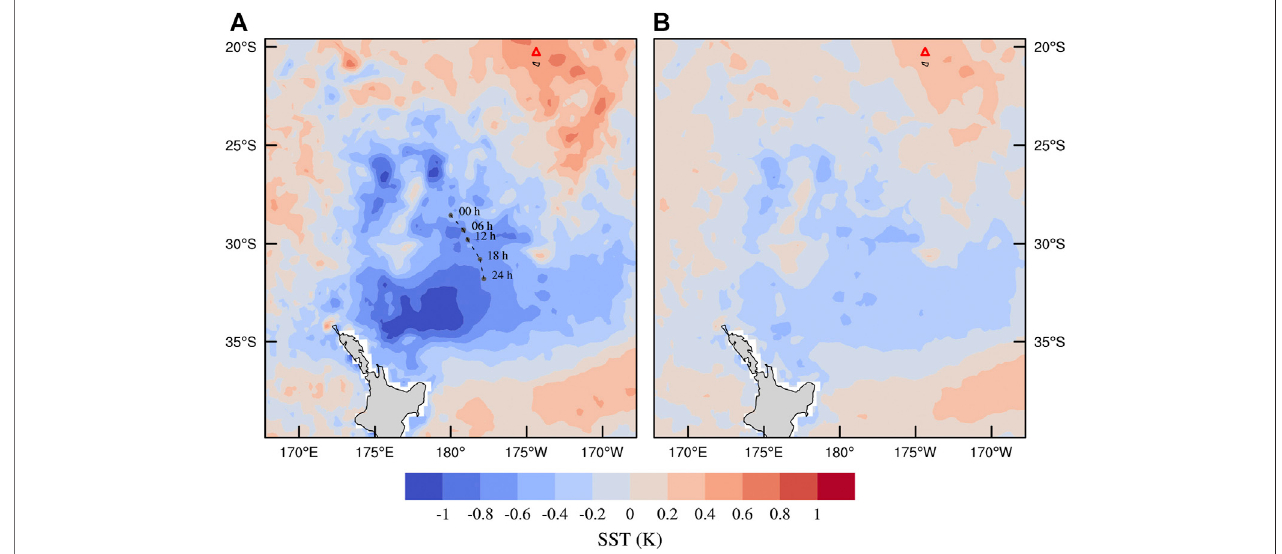
FIGURE6| Difference ofaveragedsea surfacetemperature. (A) :January 15minus January13, and (B) January 15minus 3-day averageofJanuary13toJanuary 15. Gray points denote the locations of Cody on January 15, with the UTC time at the right.